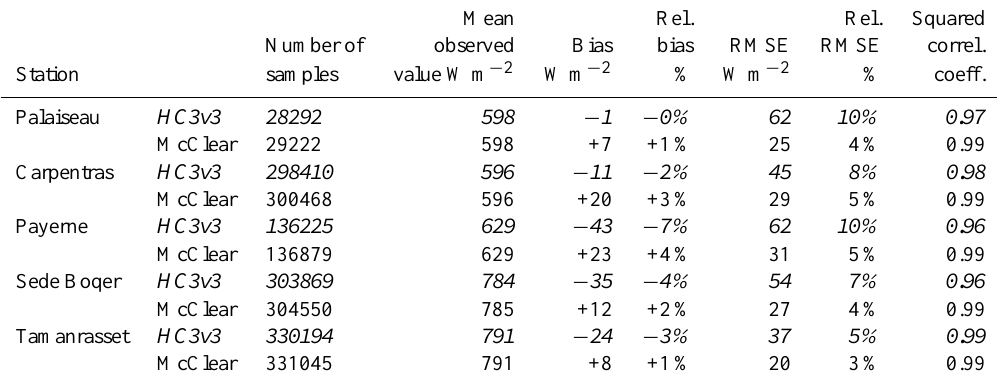
Table 6. Comparison between clear-sky global irradiances on a horizontal surface measured by BSRN and estimated by HelioClim-3v3 (HC3v3, in italics) or by McClear.